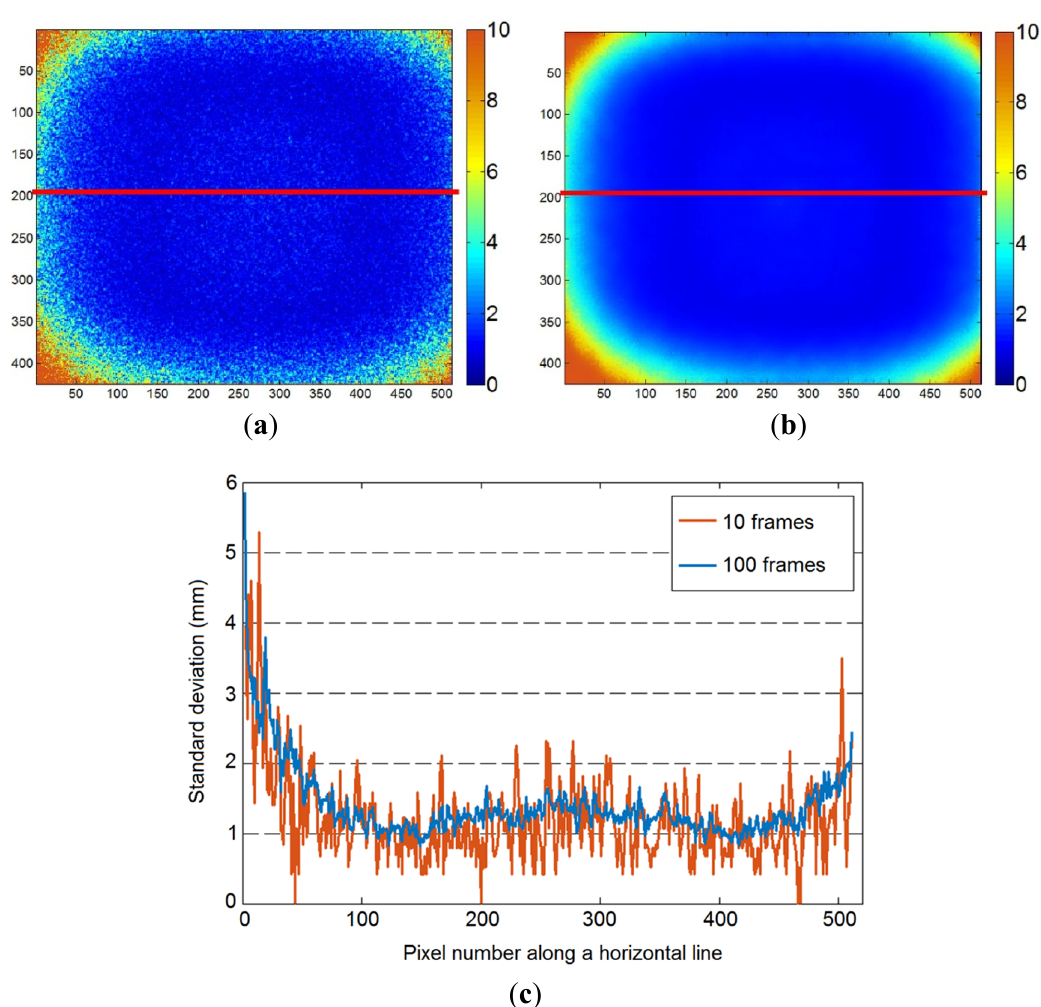
Figure 3. Visualization of color-coded standard deviation calculated for each pixel over ( a ) 10 successive frames, and ( b ) 100 successive frames; ( c ) Observation of standard deviations along a line of pixels (see red line) in the set of 10 frames (orange) and 100 frames